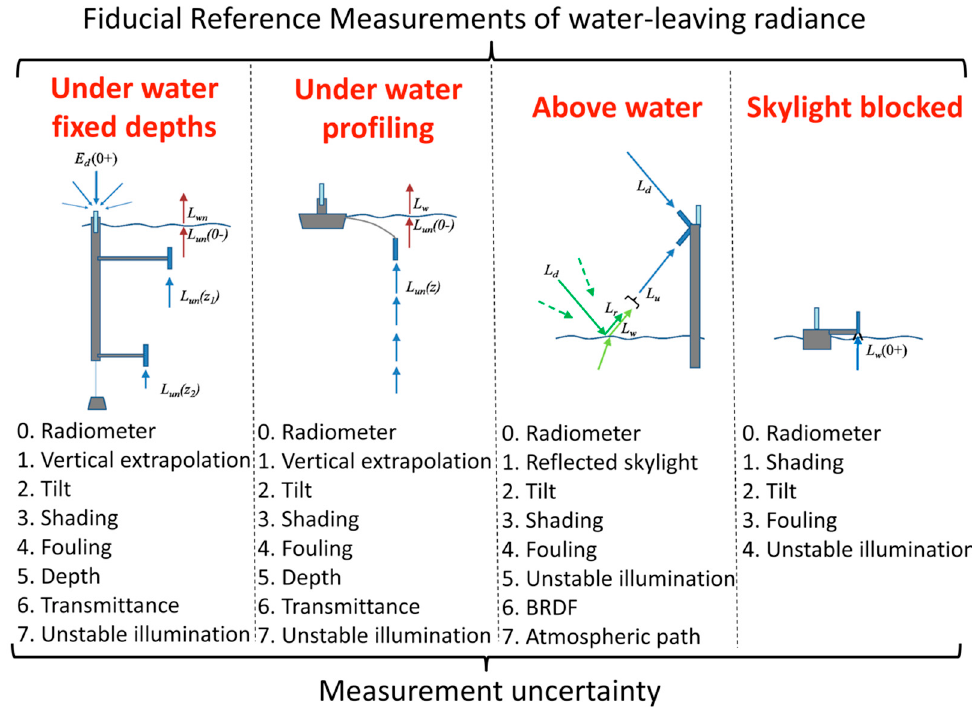
Figure 3. Summary of sources of uncertainty for the four generic families of method for measurement of water-leaving radiance. Reproduced with permission from [28].